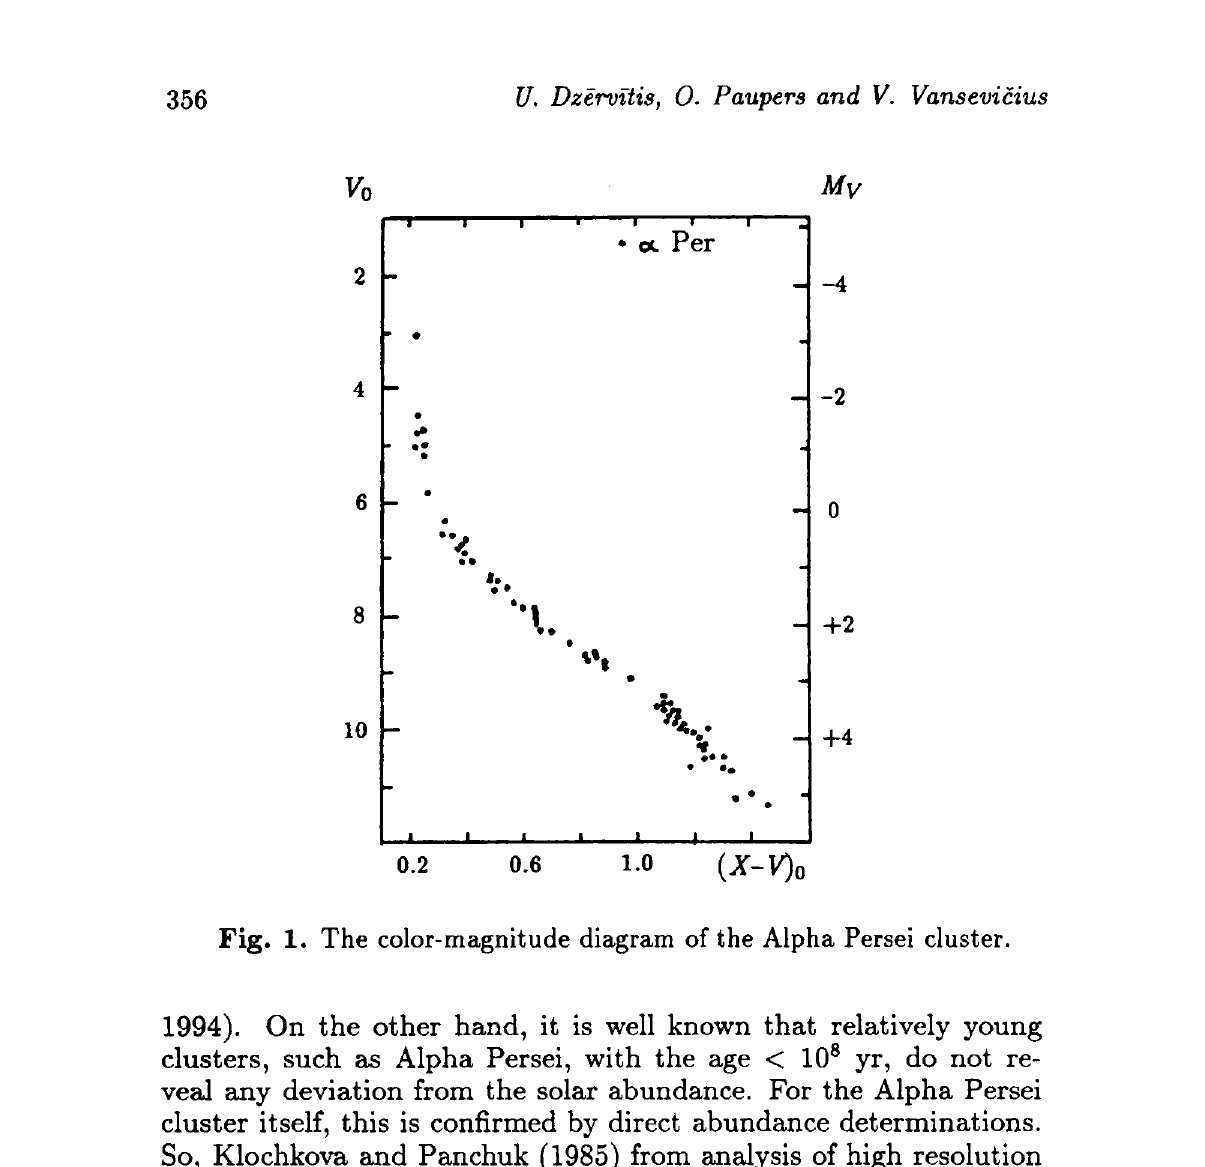
Fig. 1. The color-magnitude diagram of the Alpha Persei cluster.